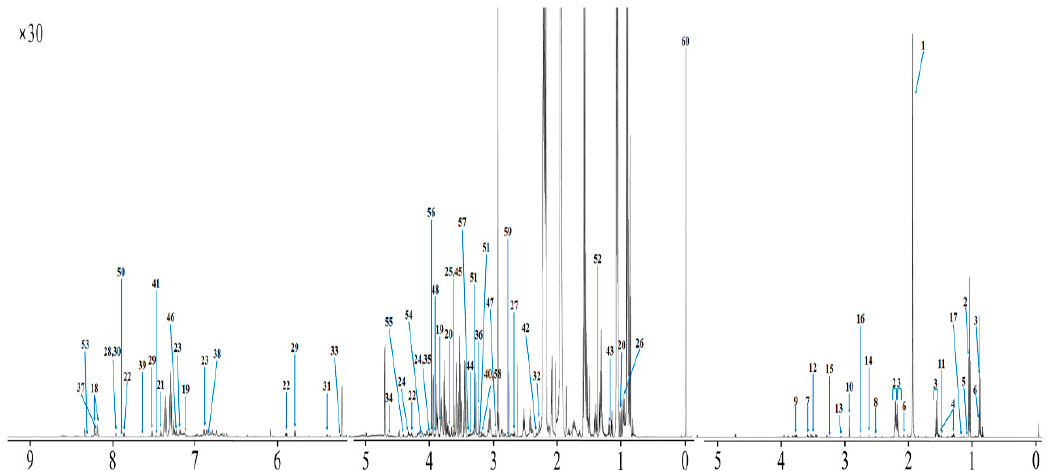
Figure 1. The representative spectrum 1 H-NMR spectroscopy obtained from Hanwoo steers rumen fluid. Metabolite spectra numbers: ( 1 ) acetate, ( 2 ) propionate, ( 3 ) butyrate, ( 4 ) valerate, ( 5 ) isobutyrate,